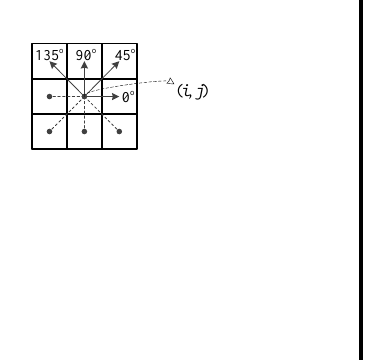
Figure 9. Four directions of high frequency sub-band 3 × 3 neighborhood.